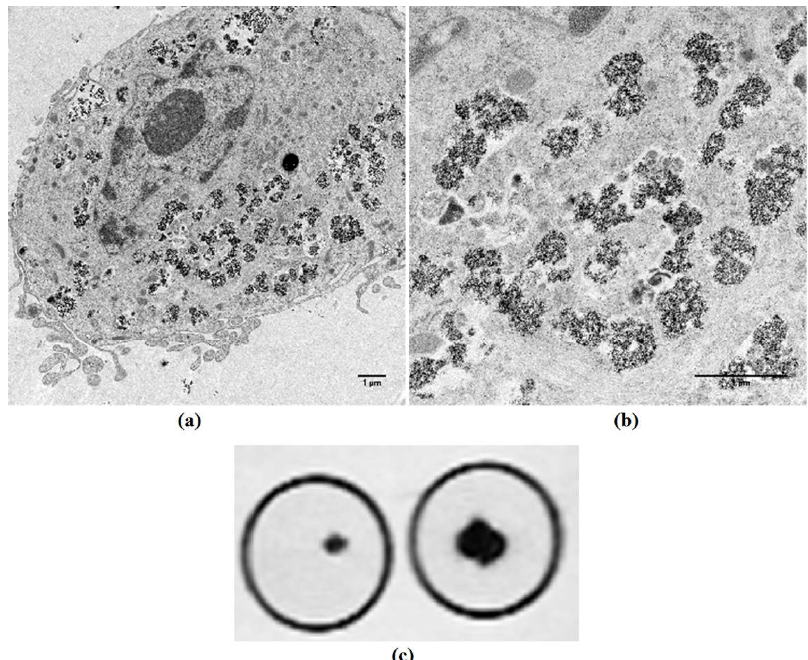
Figure 6. mms6 expression decreases with time in culture. MSCs were transfected with a pcDNA 3.1 plasmid containing either a wild‐type (yellow) or codon‐optimized (green) mms6 gene with an added GFP‐tag at the C terminus. The percentage of cells demonstrating GFP fluorescence was assessed by Fluorescence‐activated cell sorting (FACS) analysis at different times in culture.